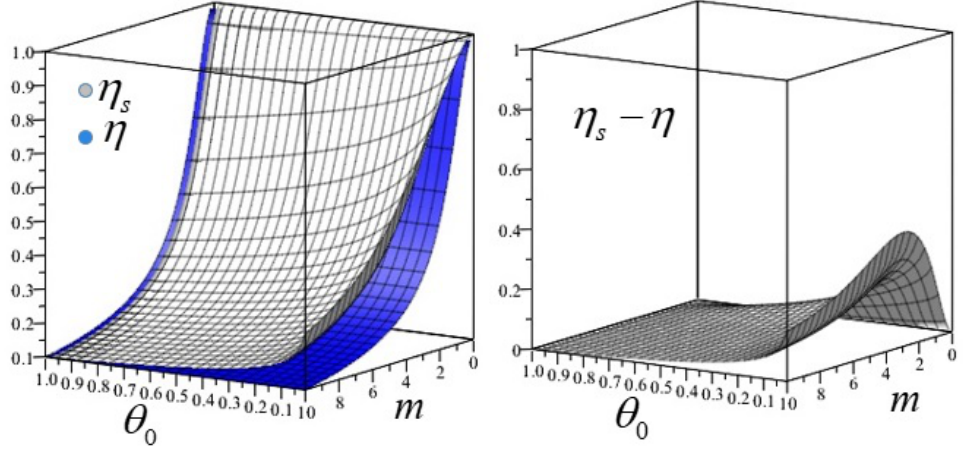
Figure 3. The plot of efficiency η s (41) and η (44) as a function of θ 0 and m ( left ) and a plot of the difference between this efficiency and the classical formula (44) ( right